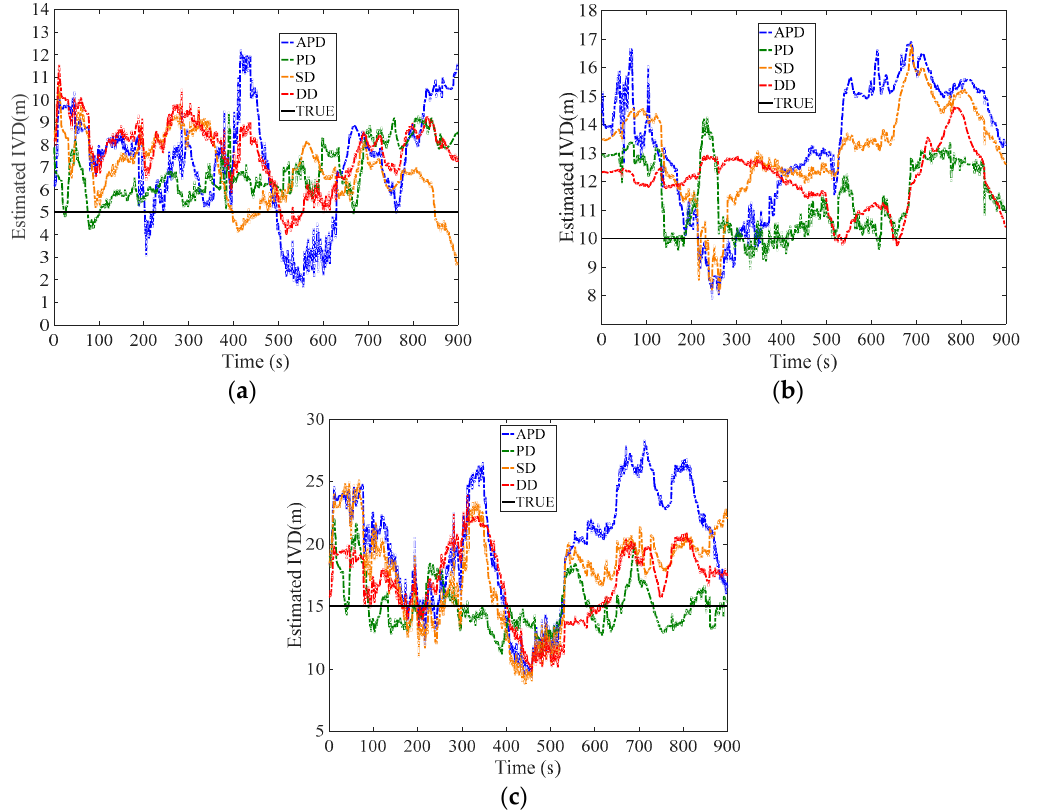
Figure 18. Dynamic experiments with roadside tree covering condition, ( a ) Baseline = 5 m, ( b ) Baseline = 10 m, ( c ) Baseline = 15